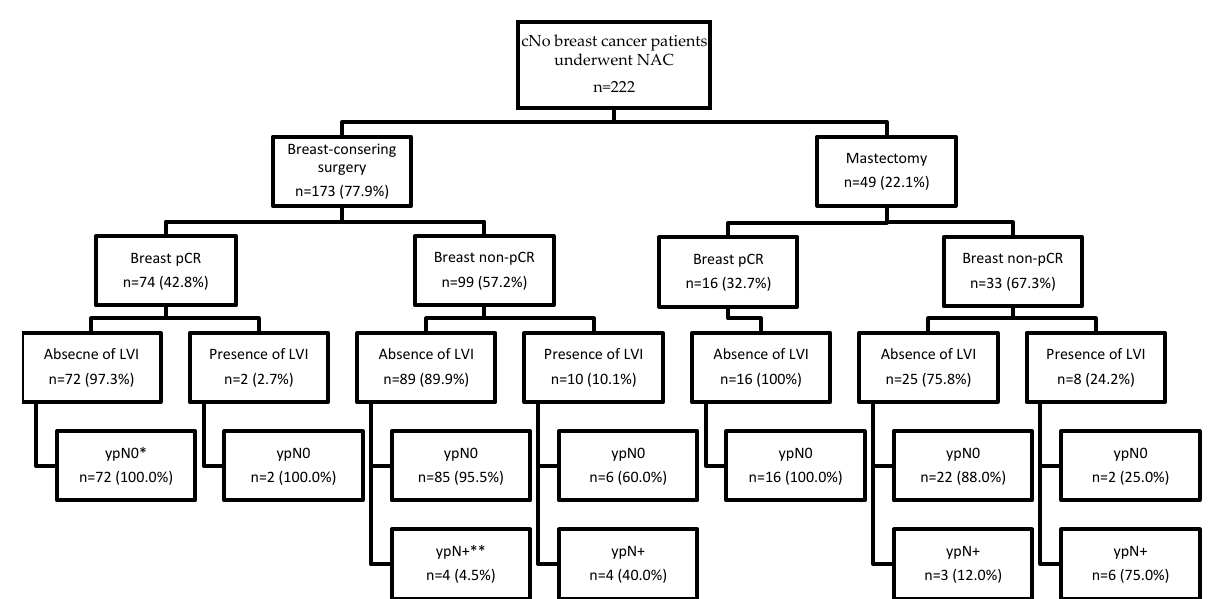
Figure 2. Results of axillary lymph node status for patients with clinically node-negative breast cancer after neoadjuvant chemotherapy stratified by different surgical procedures, tumor response in the breast, and presence or absence of LVI. cN0, clinically node-negative; NAC, neoadjuvant chemotherapy; pCR, pathologic complete response; LVI, lymphovascular invasion. Breast pCR was defined as residual invasive carcinoma in the breast after neoadjuvant chemotherapy. * ypN0 was defined as no tumor cells in the axillary lymph nodes after neoadjuvant chemotherapy. ** ypN+ was defined as the presence of any tumor cells in the axillary lymph nodes after neoadjuvant chemotherapy, including isolated tumor cells ( ≤ 0.2 mm), micrometastases (>0.2 mm and ≤ 2 mm), or macrometastasis (>2 mm).